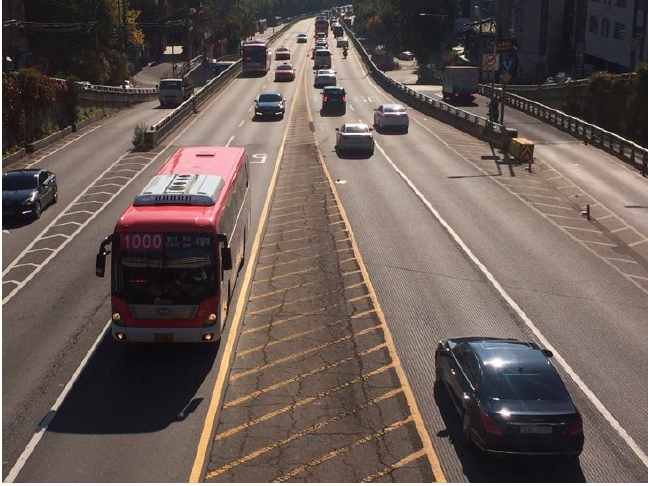
Figure 3. Measurement of actual vehicle distribution.